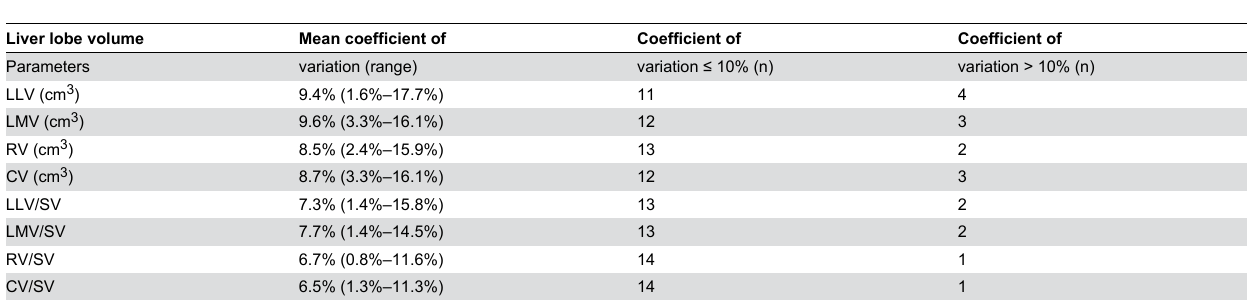
Table 2. Interobserver variability of each liver lobe volume parameter between two measurements on 9th weekend.